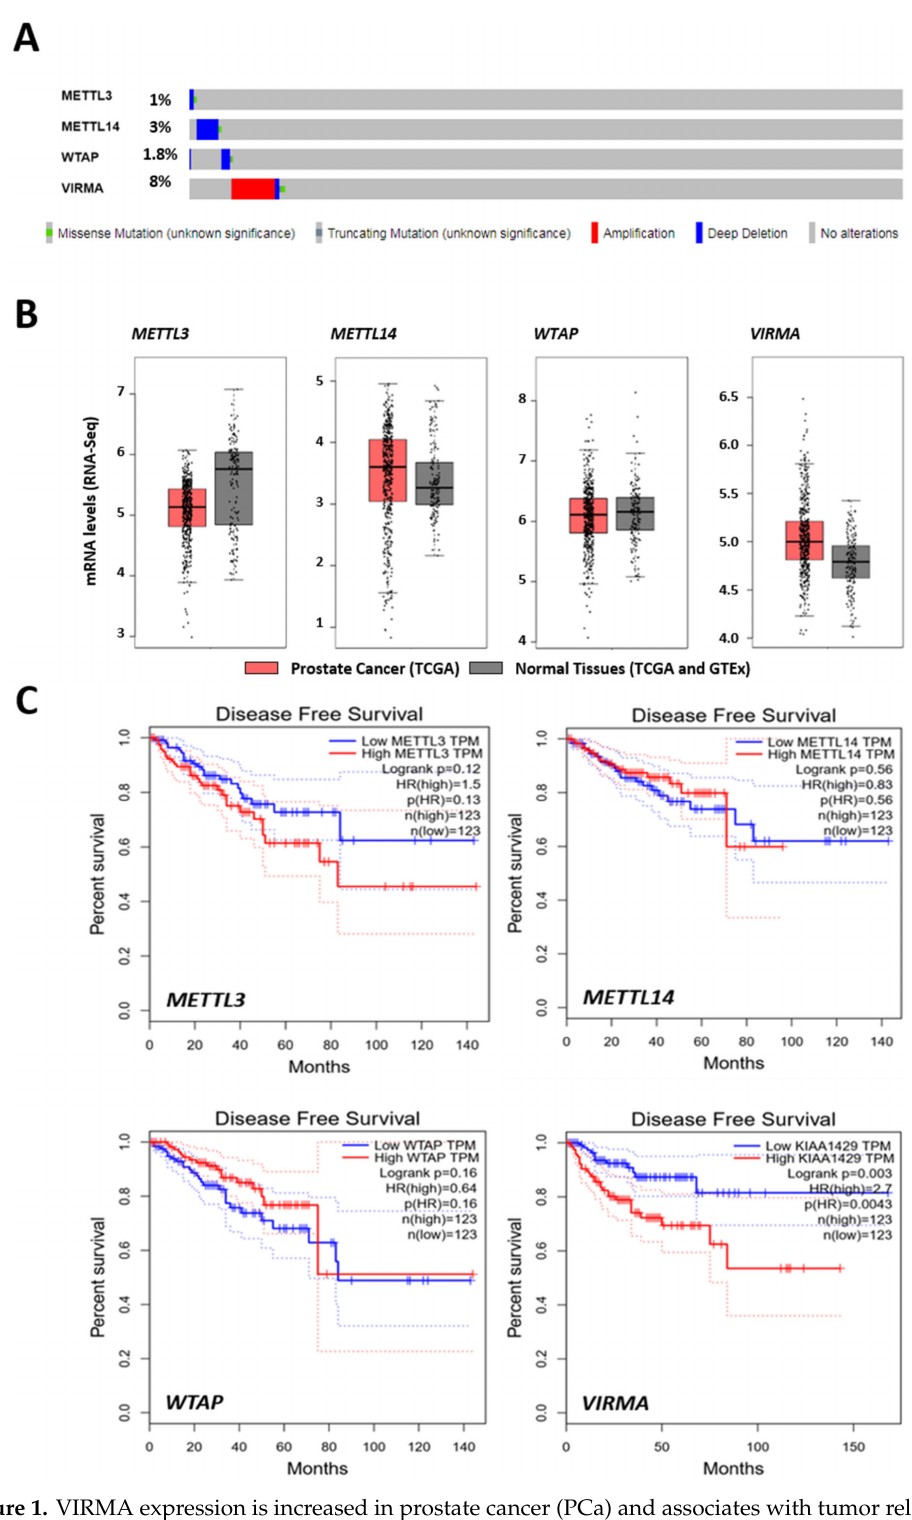
Figure 1. VIRMA expression is increased in prostate cancer (PCa) and associates with tumor relapse. ( A ) Alteration frequency of METTL3, METTL14, WTAP, and VIRMA in PCa TCGA cohort ( n = 492). ( B ) mRNA expression levels of m 6 A modifying enzymes in clinical tissue samples of The Cancer Genome Atlas (TCGA) and GTEx prostate adenocarcinoma ( n = 492, red boxplot) and adjacent normal specimens ( n = 152, grey boxplot). ( C ) Disease-free survival curves of patients with high mRNA expression (red line) and with low mRNA expression (blue line) (Mantel–Cox